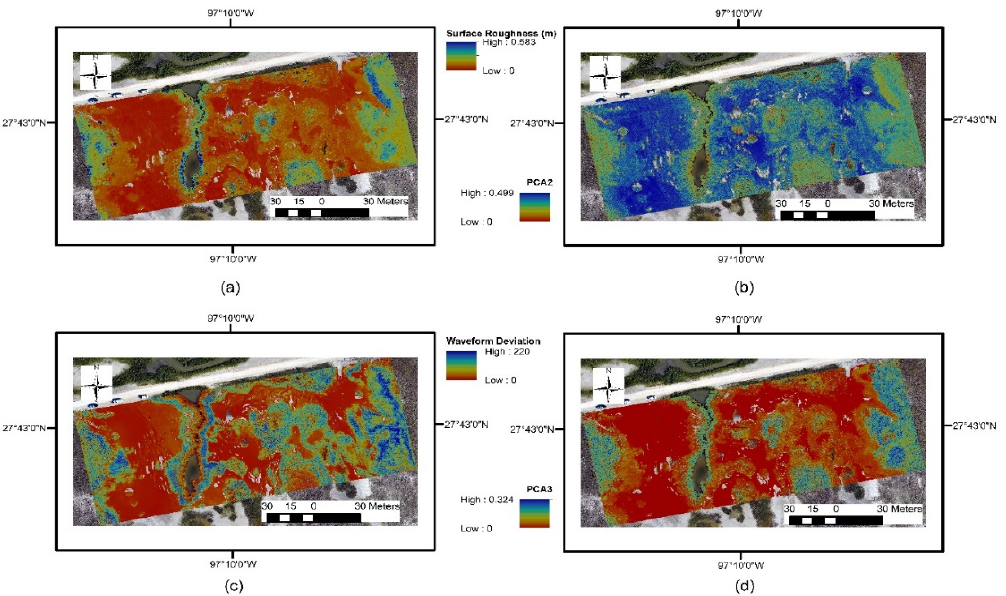
Figure 4. ( a ) Surface roughness ( σ z ), ( b ) principal component analysis (PCA) eigenvalue second dimension ( λ 2 ) , ( c ) median of the waveform deviation ( M D ) , and ( d ) PCA eigenvalue third dimension ( λ ) are presented as rasters with a resolution of 0.2 m. 3